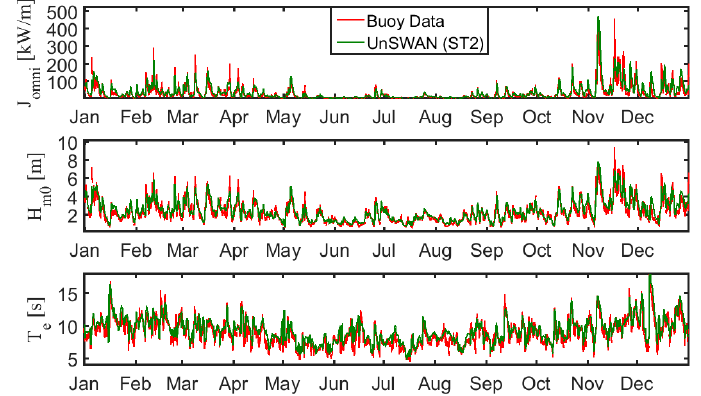
Figure 3. Hourly time ‐ series comparison of three representative International Electrotechnical Commission (IEC) wave resource parameters between UnSWAN (ST2) predictions and observed data over the one ‐ year period of 2009 at NDBC Buoy 46050. The open ‐ boundary condition of UnSWAN is forced with the model output of WWIII, using the ST2 physics package.